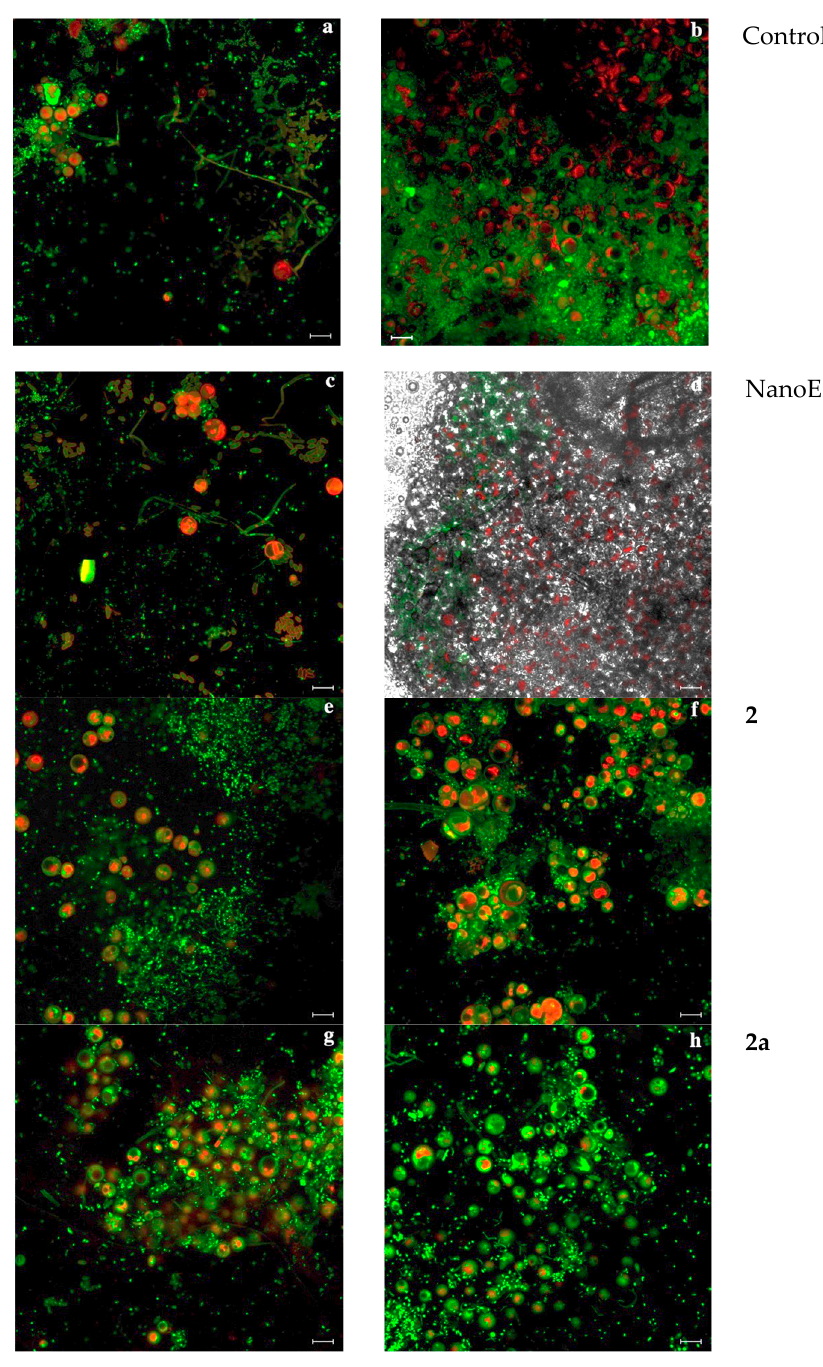
Figure 8. Biofilm behavior on marble probes after incubation for 90 days. Inner and outer layers